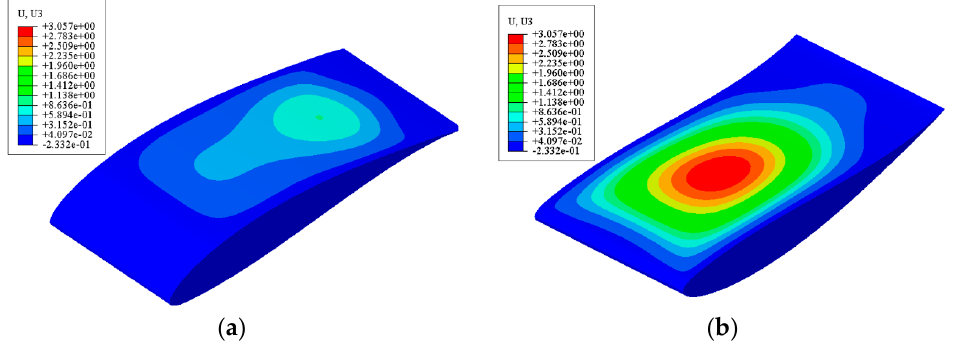
Figure 21. Membrane deformation calculated by finite element method: ( a ) Upper surface; ( b ) Lower surface.